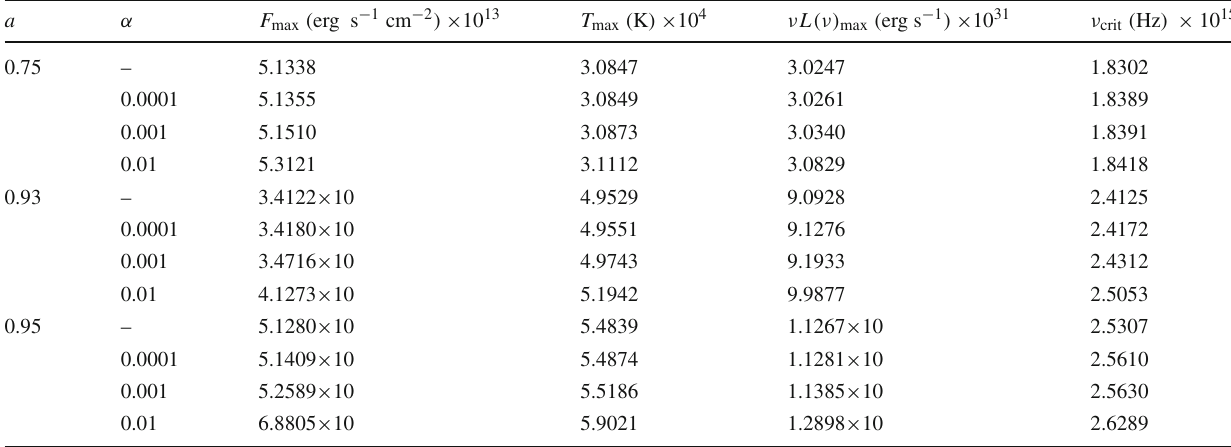
Table 2 The maximum values of the radiant energy flux F ( r ) , temperature distribution T ( r ) and the emission spectra. The cut-off frequency is also shown in last